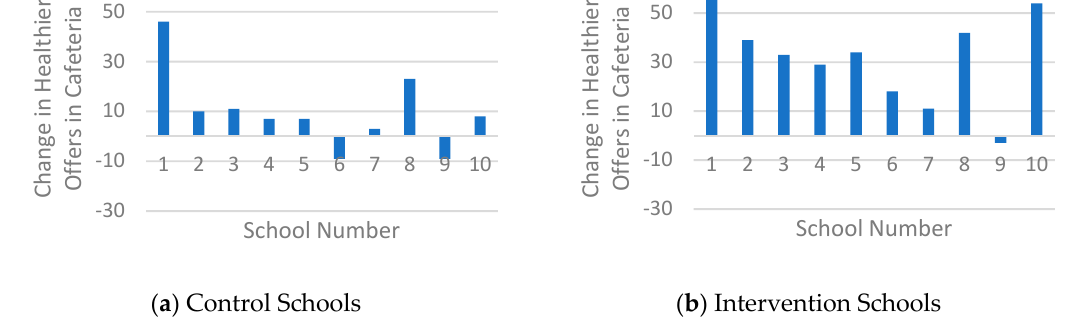
Figure 2. Histogram of the changes in healthier products available in the cafeteria.